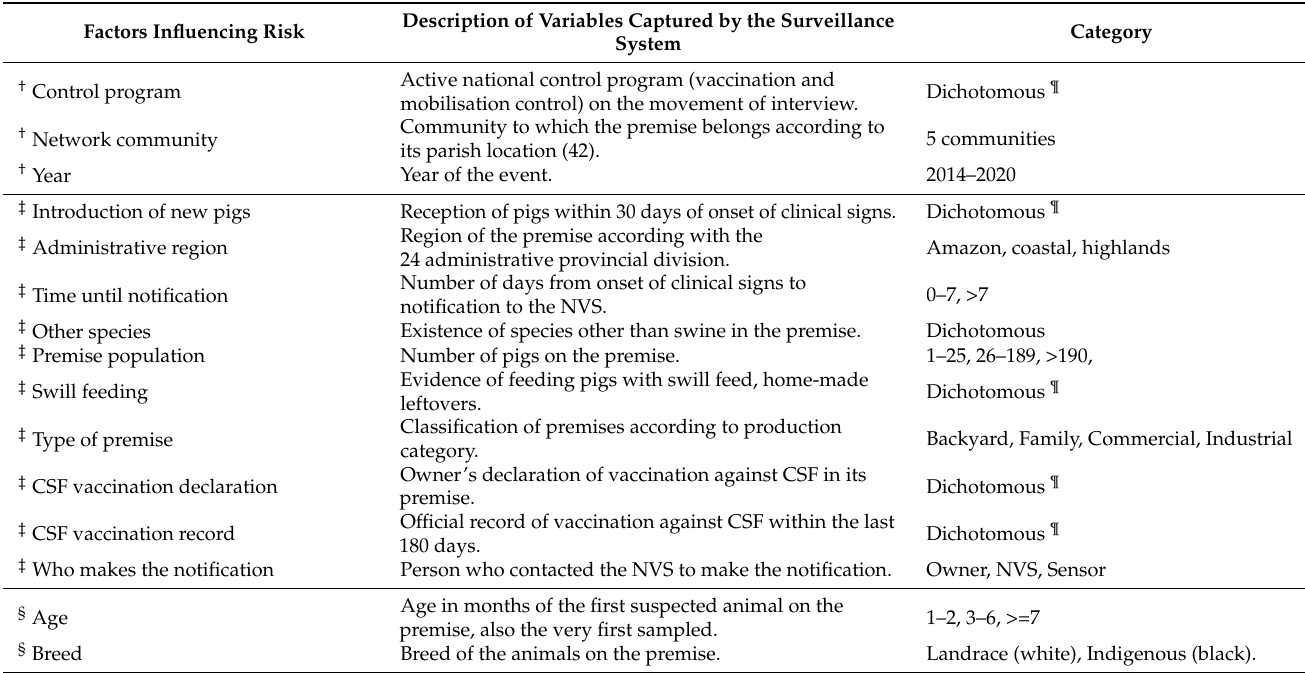
Table 1. Description of variables influencing risk and their levels. Data available in Ecuador’s CSF surveillance system from 2014 to 2020; levels grouped by risk